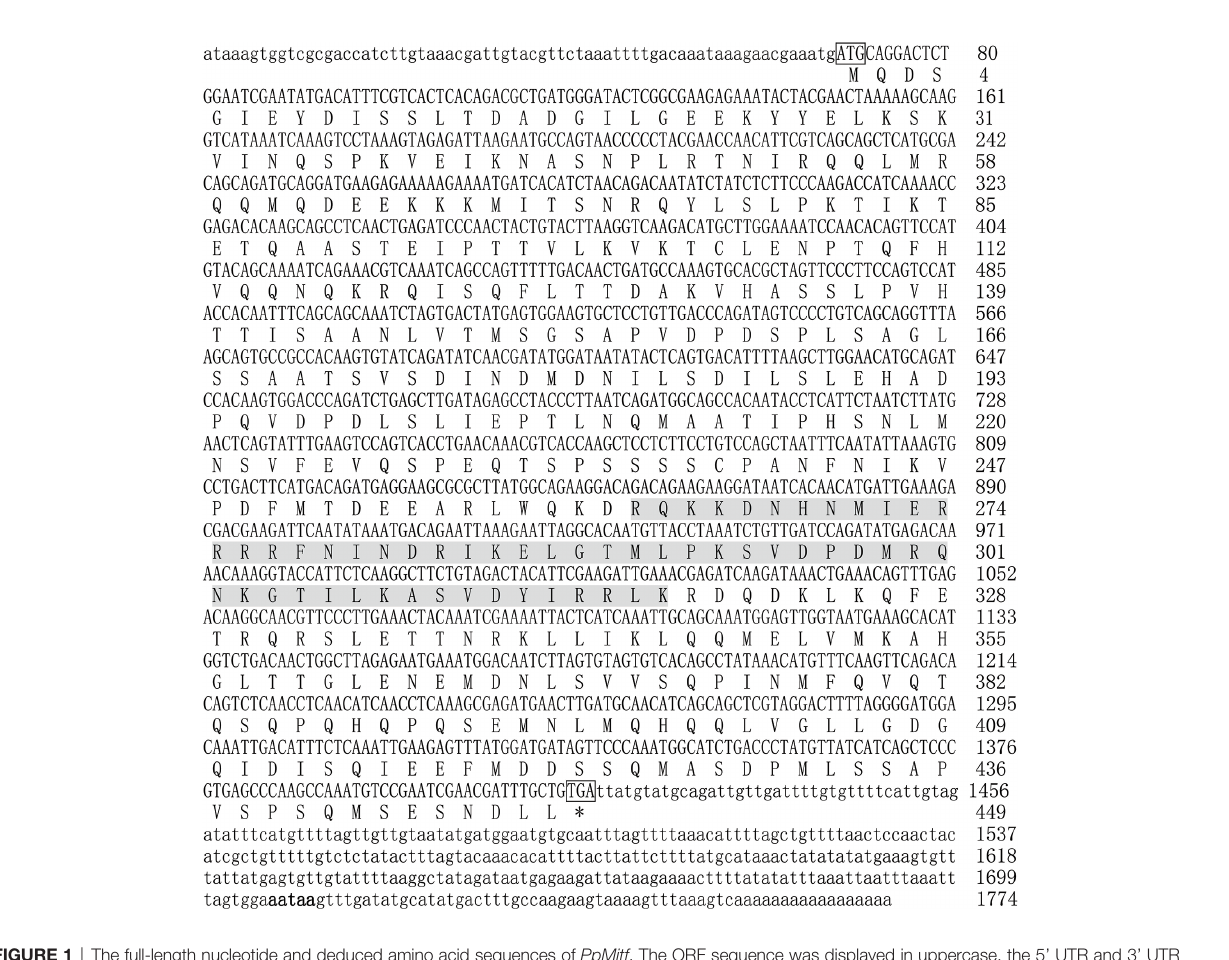
FIGURE 1 | The full-length nucleotide and deduced amino acid sequences of PpMitf . The ORF sequence was displayed in uppercase, the 5 ’ UTR and 3 ’ UTR sequences were displayed in lowercase. The initiation codon (ATG) and termination codon (TGA) were boxed. The putative bHLH-LZ domains were boxed in gray. The signal peptide (aataa) was marked in boldface. * meant no amino acid was